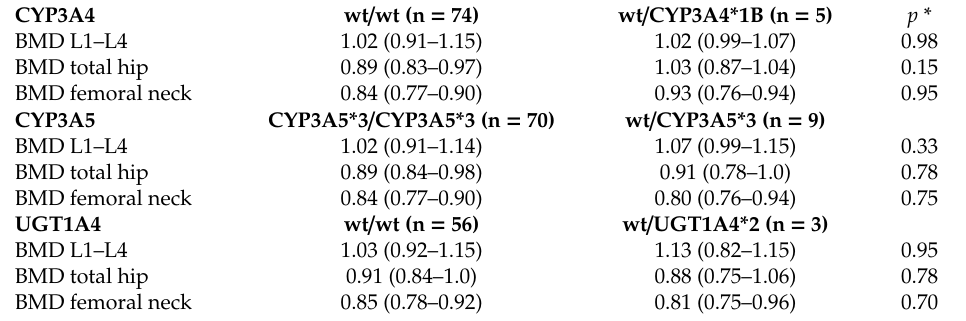
Table 4. Di ff erences in BMD according to CYP3A4, CYP3A5 and UGT1A4 polymorphisms during treatment with anastrozole.